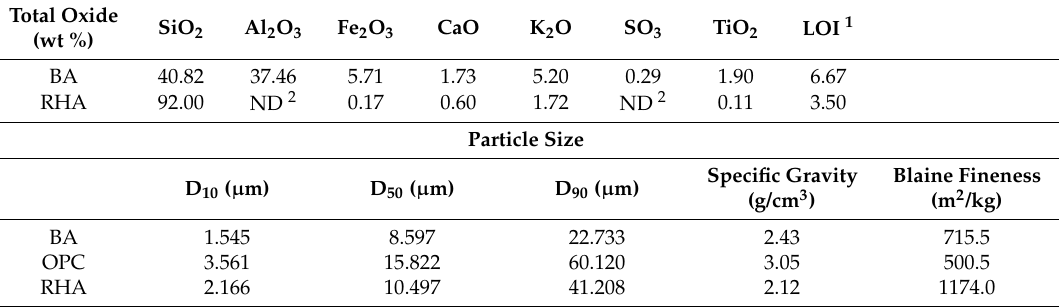
Table 2. Chemical and physical characteristics of the precursor